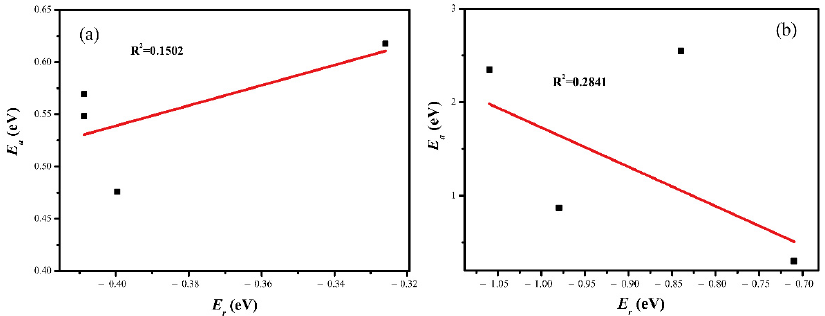
Figure 7. Relationship between the activation barrier and the reaction energy via ( a ) CO 2 +H → COOH and ( b ) CO 2 +H → HCOO.